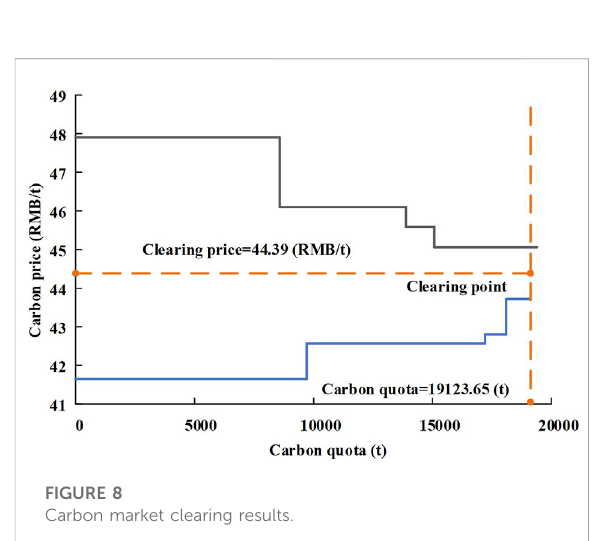
FIGURE 8 Carbon market clearing